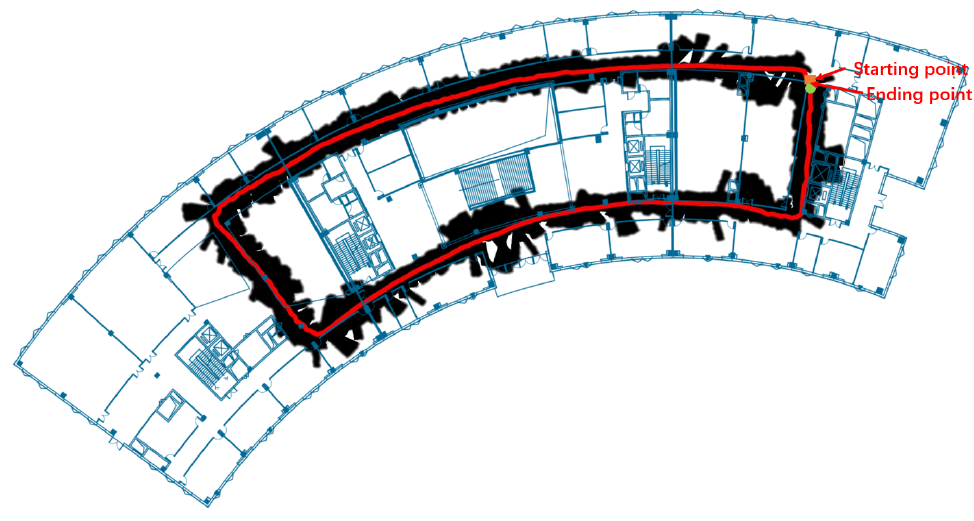
Figure 14. Plotting of 2D mapping result of Scenario